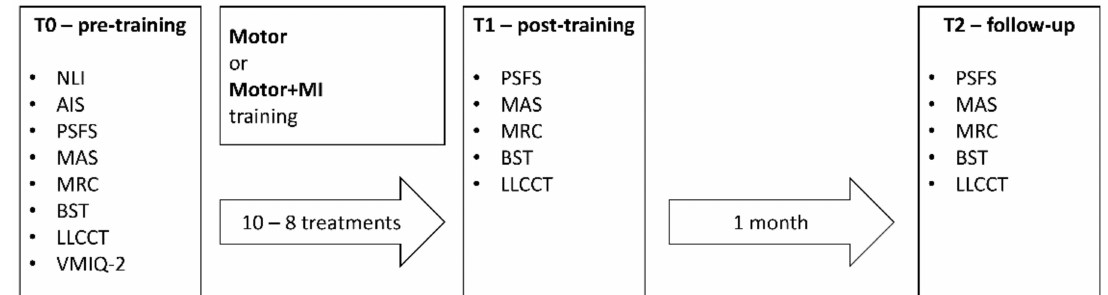
Figure 1. The 4 phases of the study. Evaluations carried out at T0, T1 and T2. NLI = Neurological Level of Injury [13]; AIS = ASIA Impairment Scale [48]; PSFS = Penn Spasms Frequency Scale [49]; MAS = Modified Ashworth Scale [50]; MRC = Medical Council Research scale [51]; VMIQ-2 = modified Vividness of Motor Imagery Questionnaire 2 [29]; BST = Body Sidedness Task [52,53]; LLCCT = Lower Limbs Crossmodal Congruency Task